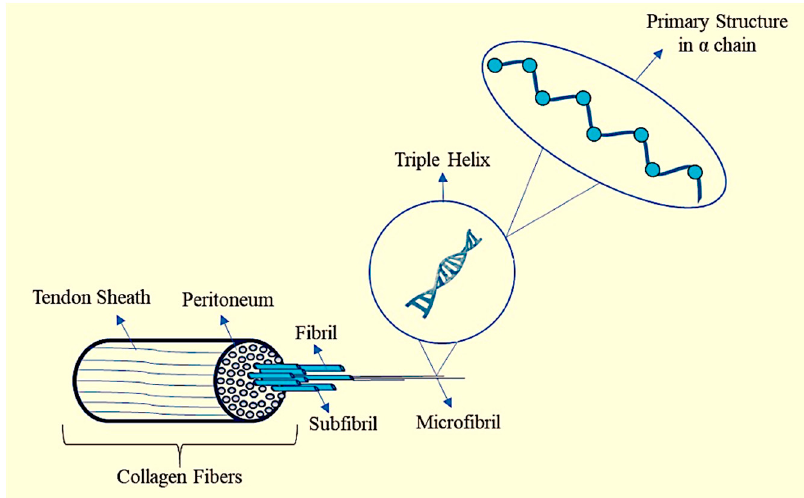
Figure 3. Structure of collagen .